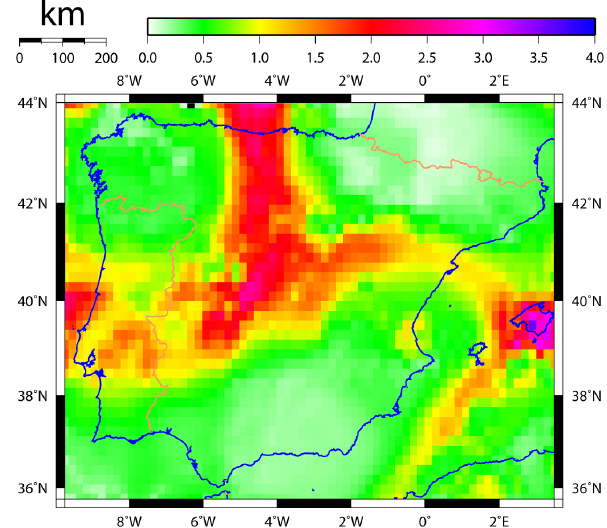
Figure 4. Derivation of the bandwidth parameters using the cata- logue data, separately grouped into shallow and deep events. Figure 5. Distribution of the bandwidth parameter c ; the higher val- ues (red and purple) that appear in low seismicity areas (central Iberian Peninsula and Balearic Islands) indicate a greater distance between events of similar size.